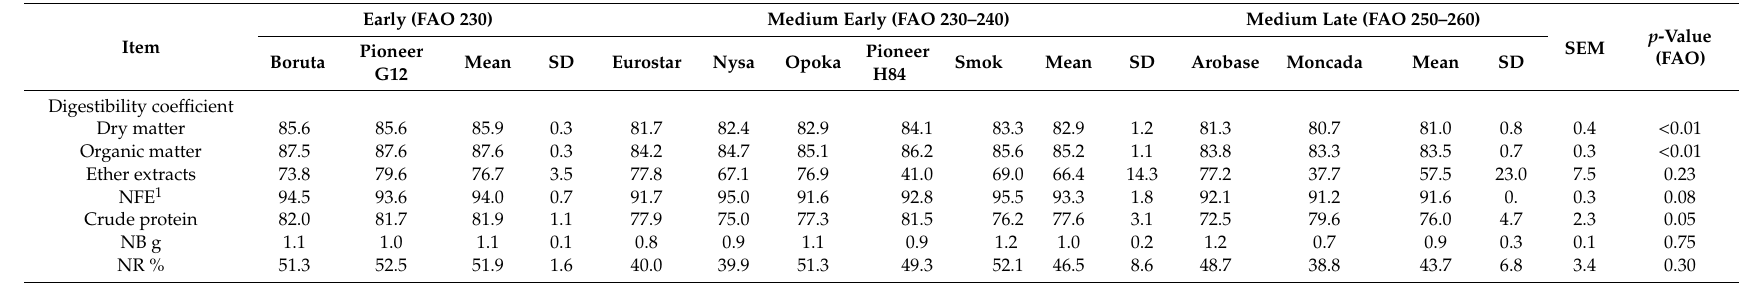
Table 5. Apparent nutrient digestibility (%), nitrogen balance (NB g), and nitrogen retention (NR %) of maize grain in broilers.